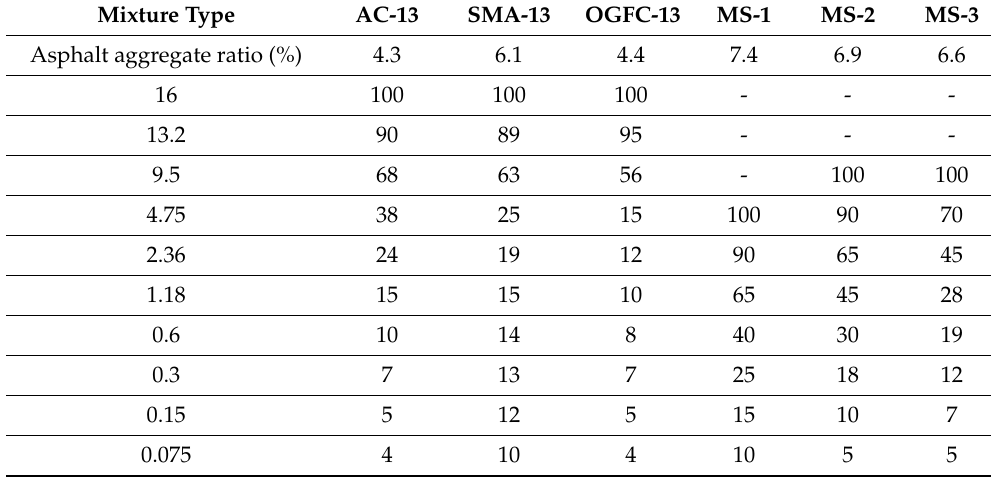
Table 4. Mixture